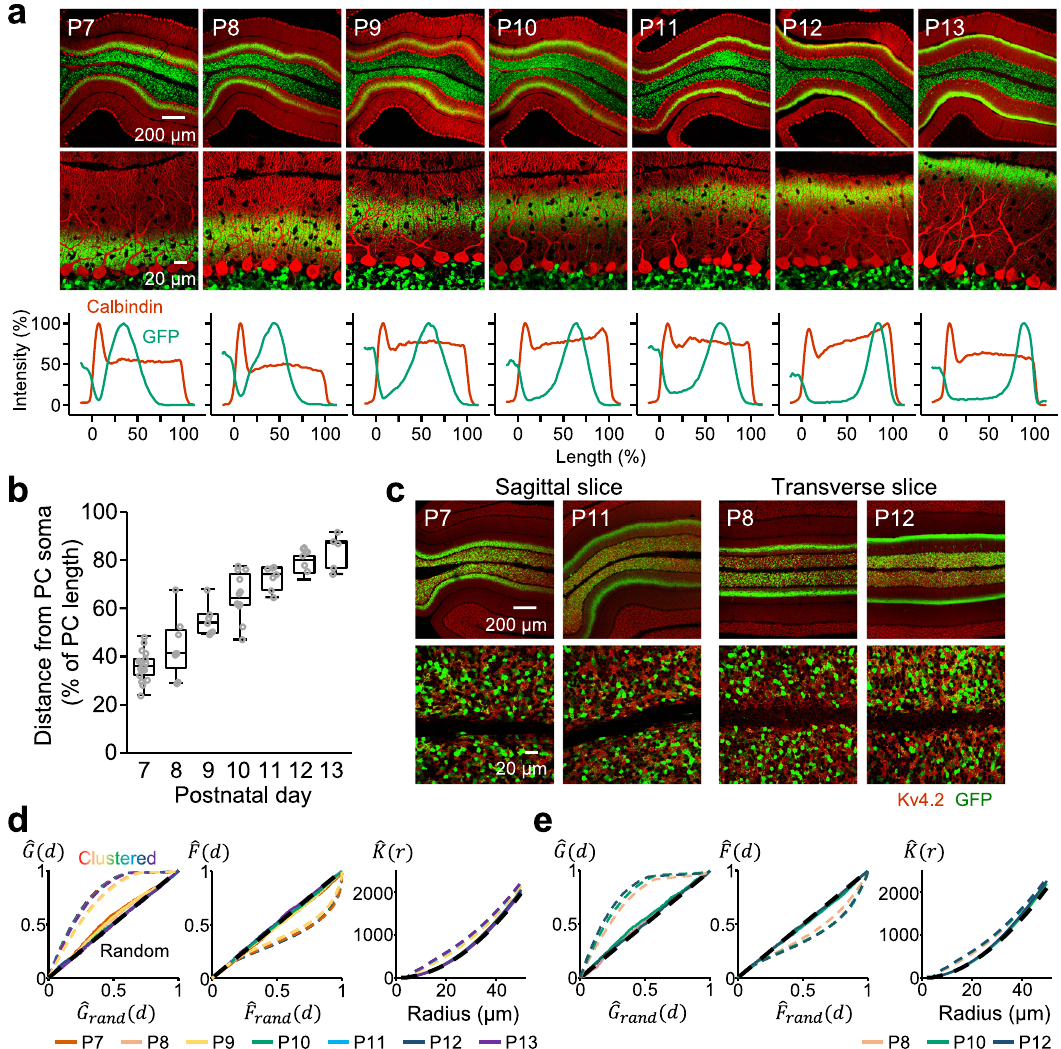
Fig. 1 Characterization of expression patterns triggered by the injection of AAV-GABR α 6-GFP into the cerebellum. a Confocal images of lobule IV/V in cerebellar sagittal slices, where AAV was injected. Expression of GFP (green) was triggered by the injection of AAV-GABR α 6-GFP on the indicated postnatal days. PCs are stained with a calbindin antibody (red). Bottom graphs show line-scan pro fi les across the PC layer and the ML. The x -axis indicates the length (shown as a percentage) from PC soma (0) to the edge of PC dendrites (100). b Distances between the labeled PF bundles and PC somas ( N = 5 – 17 mice each, 63 mice in total). The center of the PF bundles was detected by fi tting the line scan pro fi les of GFP signals (see in a ) to the Gaussian function. Data are presented as boxplots. c Confocal images of sagittal (left) or transverse (right) slices stained with a Kv4.2 antibody (red). AAV- GABR α 6-GFP (green) was injected on the indicated postnatal days. d , e The analyses of GC distributions in sagittal ( d ) or transverse ( e ) planes by the ^ G (left), ^ F (middle), or ^ K functions (right) ( N = 3 – 5 mice, 50 mice in total, 3 images per mouse). Black and colored dotted lines show the results obtained from computationally created random and clustered con fi gurations, respectively. Solid lines show the experimental